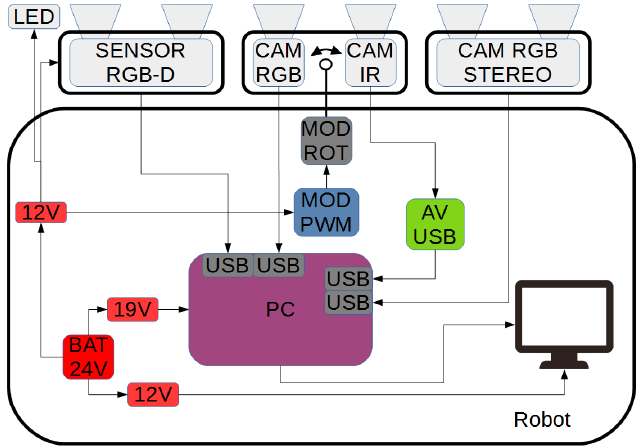
Figure 5. Block diagram of the sensory system.